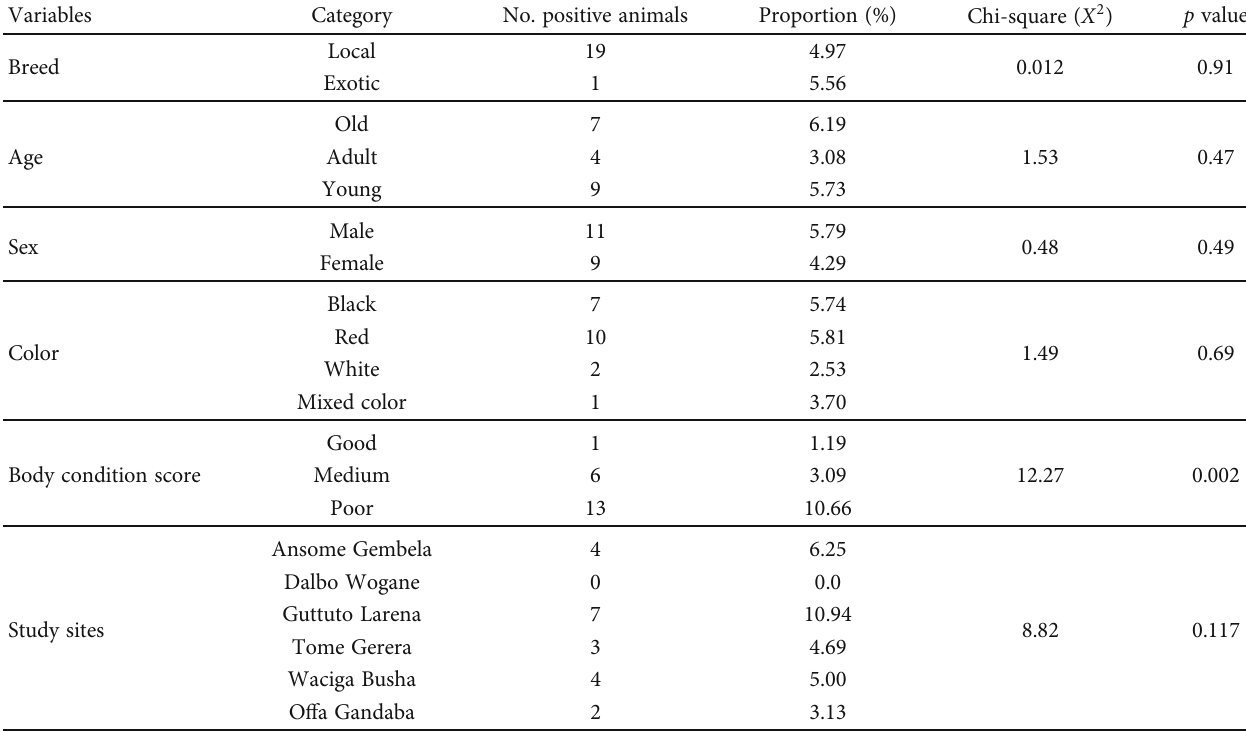
Table 2: Prevalence of Trypanosoma infection among the potential risk factors.